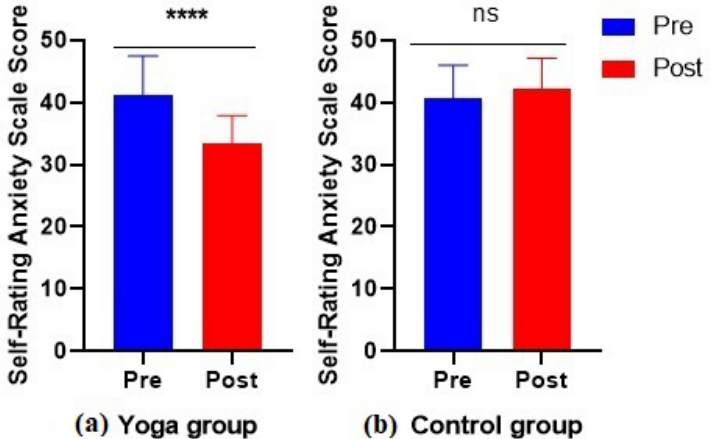
Figure 4. Results from the SAS questionnaire for two different groups ( a ) experimental group and ( b ) control group, where **** and ns represents significiant and non-significant respectively. Both groups were further divided into pre and post experimental and control group, respectively. Red and blue color represent pre and post experimental and control groups,